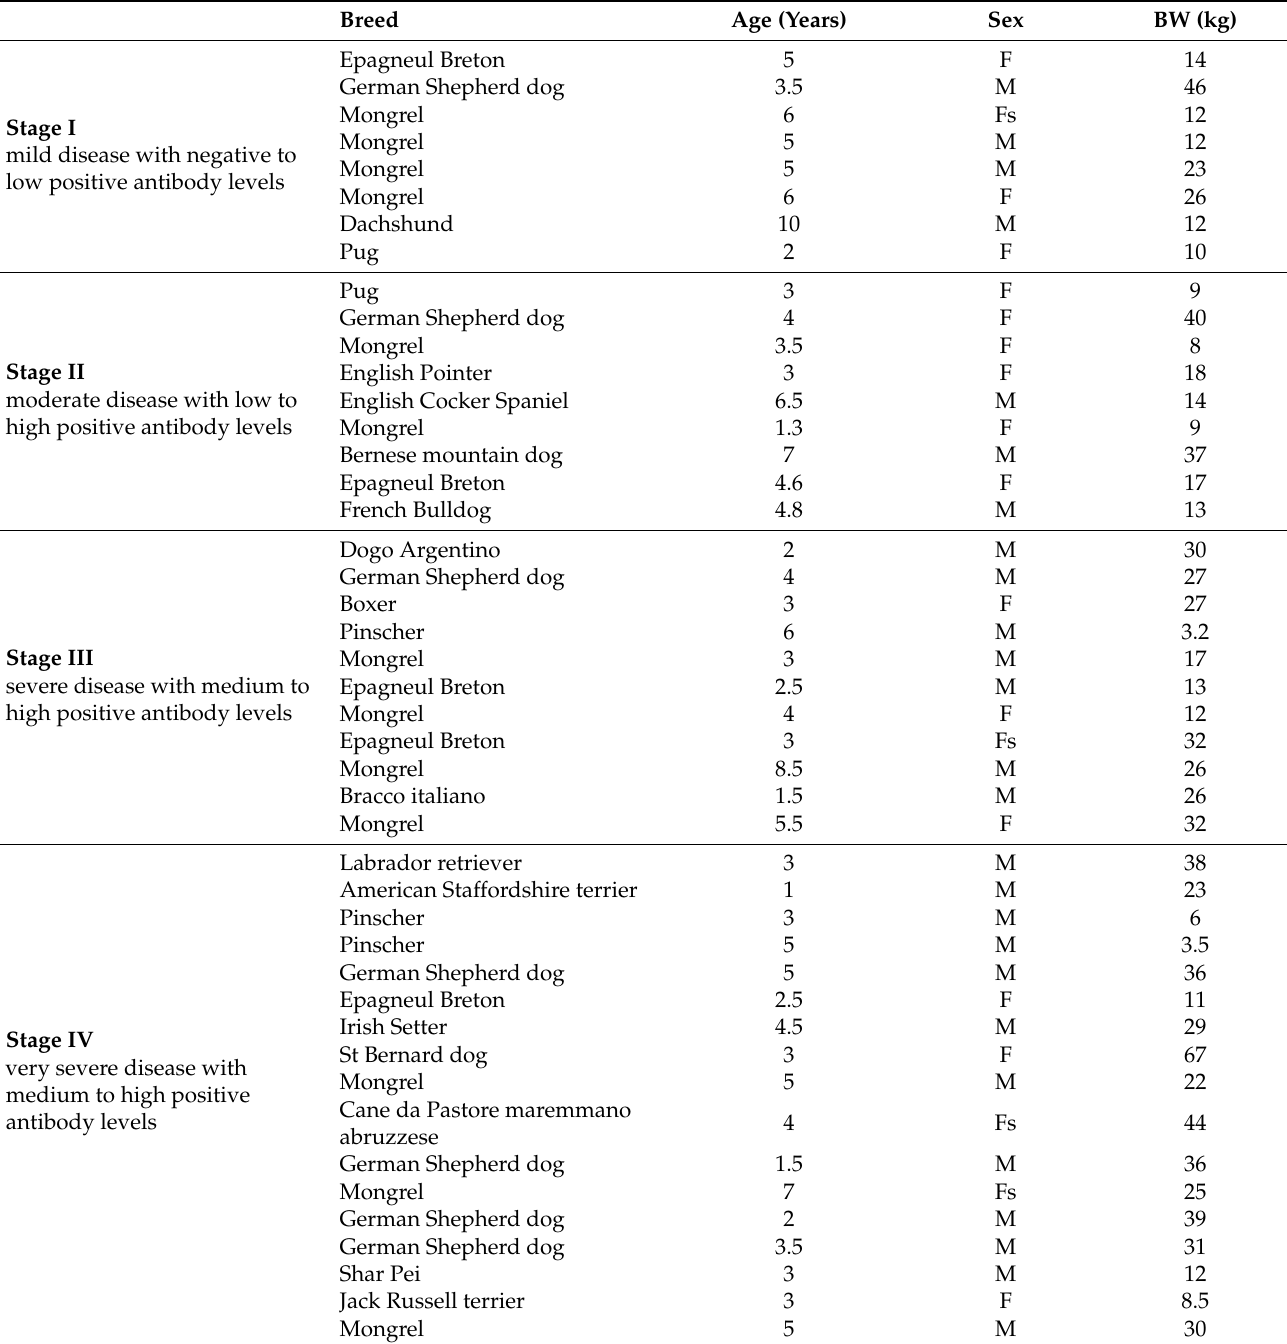
Table 2. The table reports the data (age, sex, weight) of the dogs divided into four categories according to the classification proposed by the LeishVet